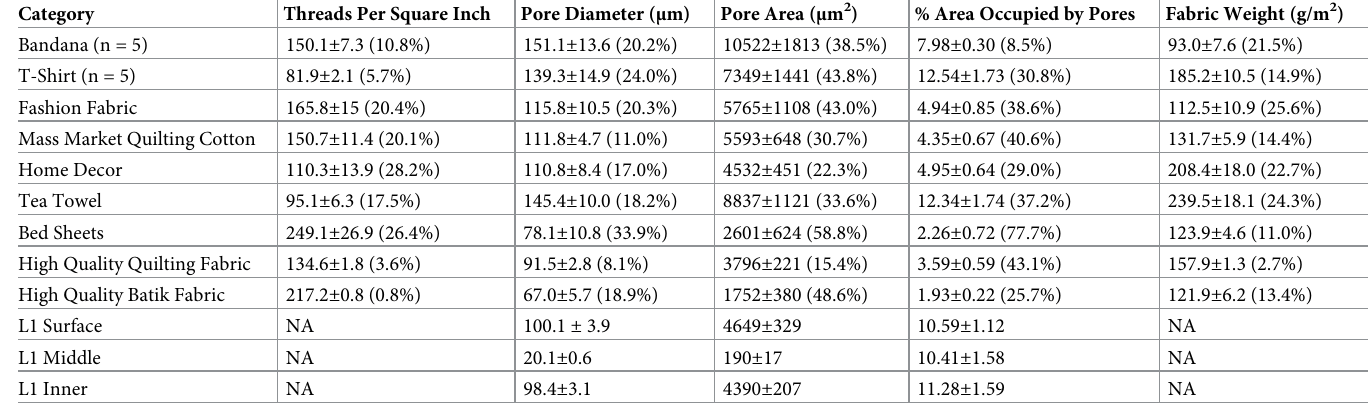
Table 2. Selected mean ± standard error (%CV) of fabric characteristics across fabric consumer categories. Category